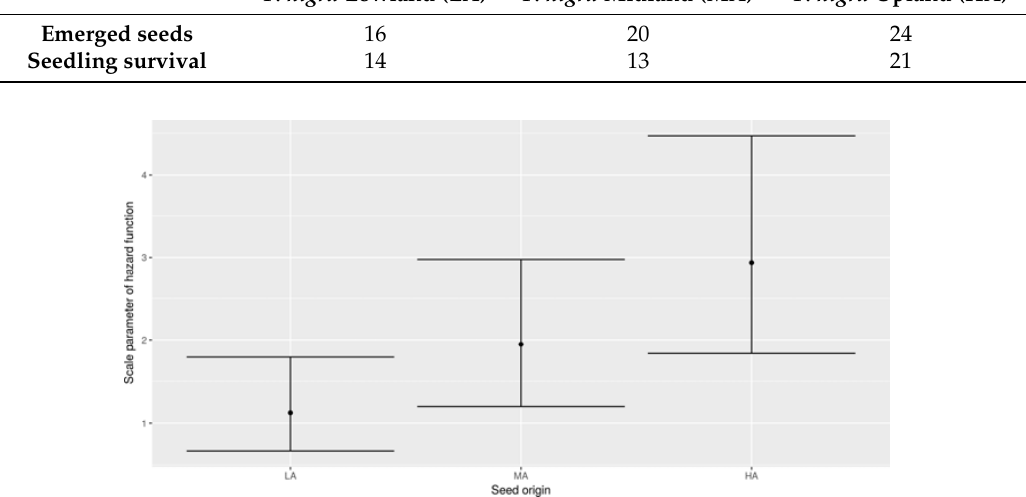
Figure 6. Scale parameter of the hazard function for emergence at the greenhouse for each seed origin (MA: P. nigra from typical distribution, HA: P. nigra from upland forests distribution, LA: P. nigra from lowland forests distribution). The error bars indicate the 95% credible